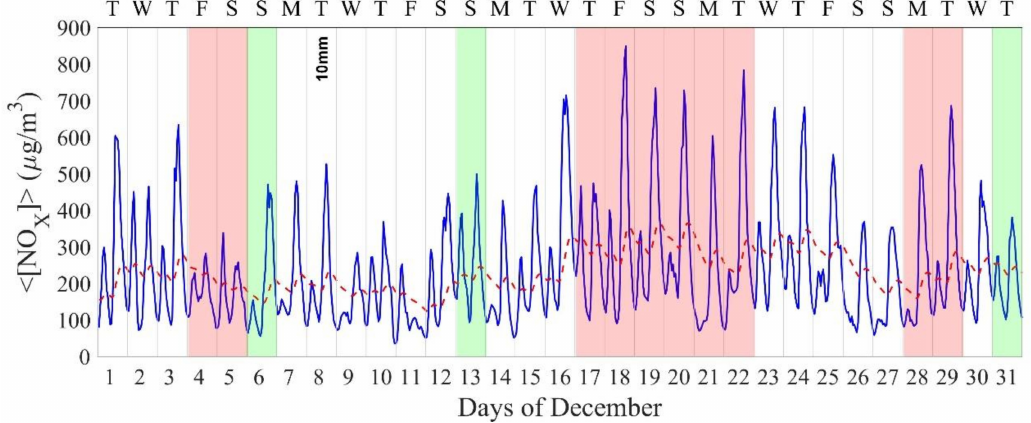
Figure 12. Nitrogen oxides concentration variation related to the total block of urban traffic (green band) and alternated plates (red band) of December 2015. The blue line is the hourly pollutant concentration. The red dashed line is the daily mean pollutant concentration. Data of daily precipitation are indicated in mm.